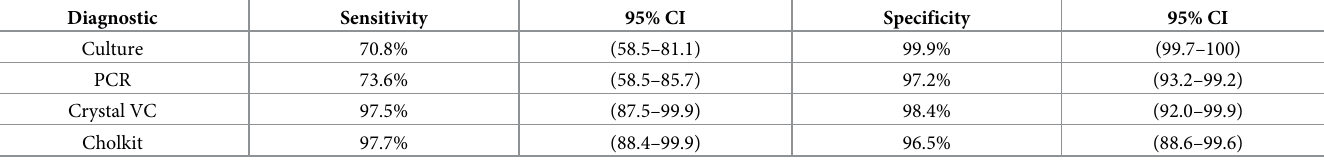
Table 3. Estimated sensitivity and specificity of four diagnostic tests for cholera in patients (95% credible intervals shown in parenthesis), using a Bayesian latent class modeling